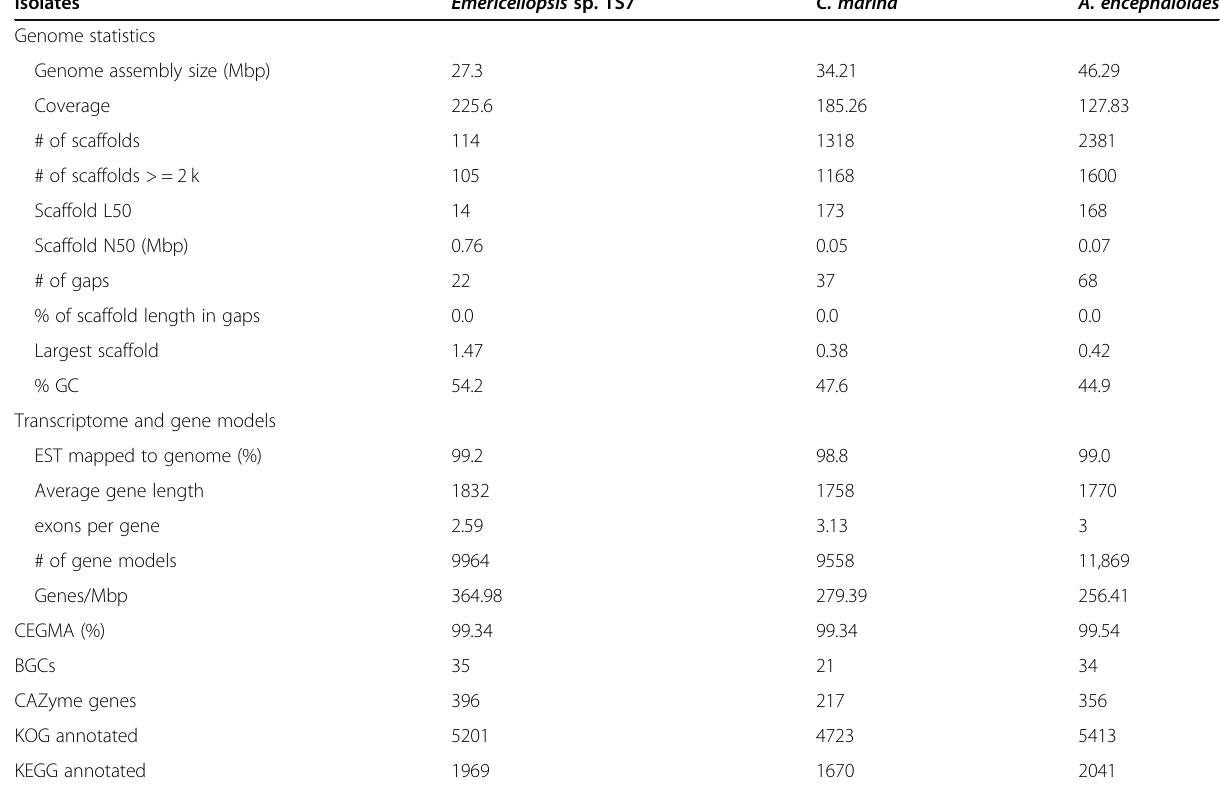
Table 1 Overview of genome assembly and gene statistics for Emericellopsis sp. TS7, Calycina marina and Amylocarpus encephaloides Isolates Emericellopsis sp.